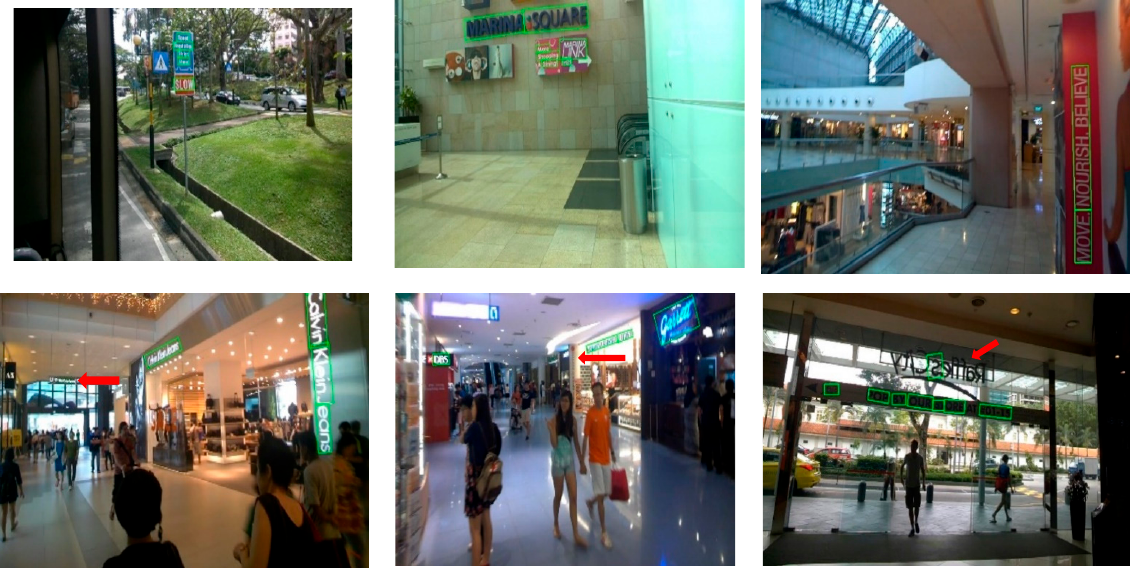
Figure 7. Some visualization results on the ICDAR2015 dataset; the arrows marked in red in the picture represent the text instances that were not detected.